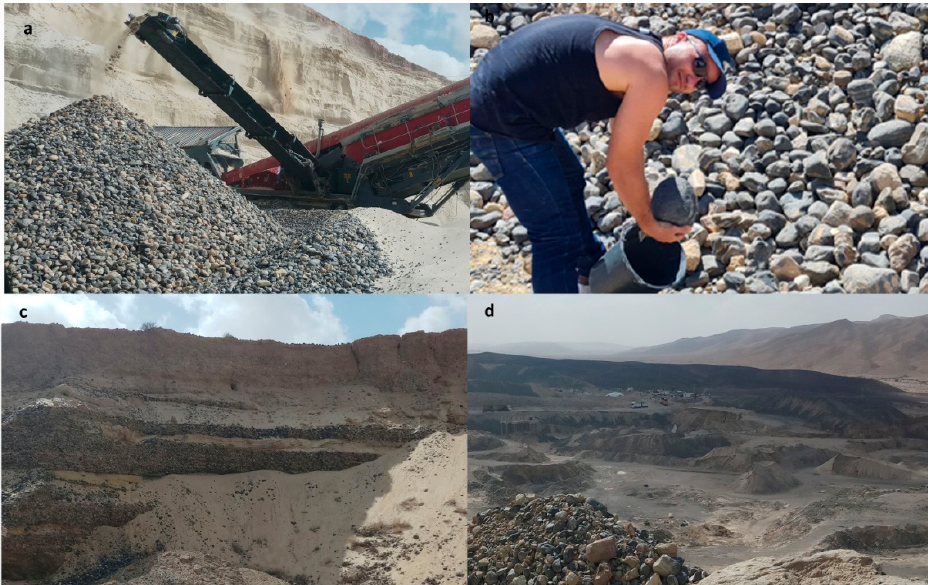
Figure 3. ( a ) The chert rock as a by-product of sand mining; ( b ) the typical sizes and shape of chert gravels; ( c ) the example of the sand section including chert “layers”; ( d ) the view of the retained area of the former open pit.